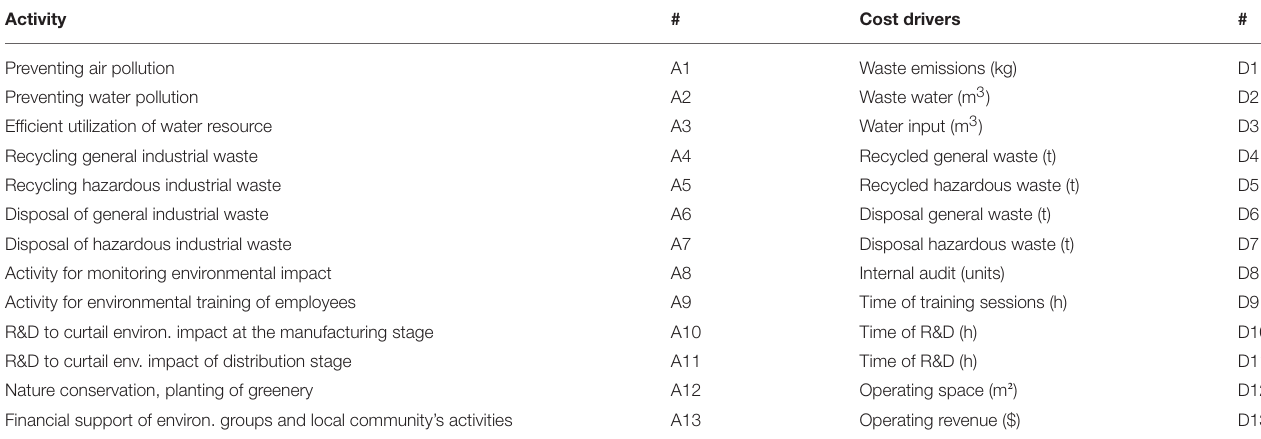
TABLE 1 | Company’s activities and drivers considered by Tsai et al. (2010). Activity # Cost